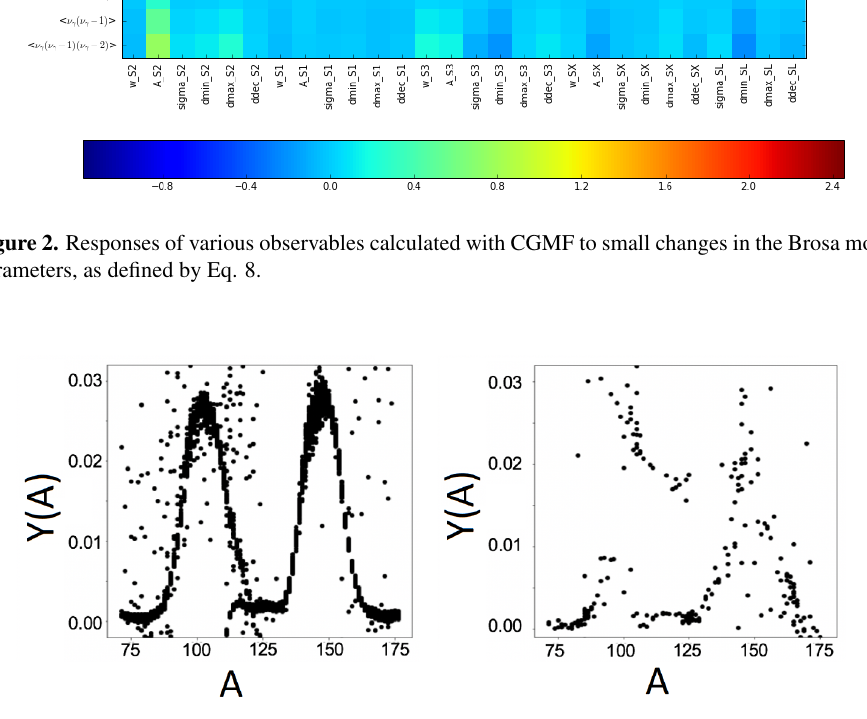
Figure 3. Results of the MDN attempt to learn Y ( A ) for a sparse data set of 238 Pu(sf) (left) using transfer learning with 252 Cf(sf) (right) without transfer